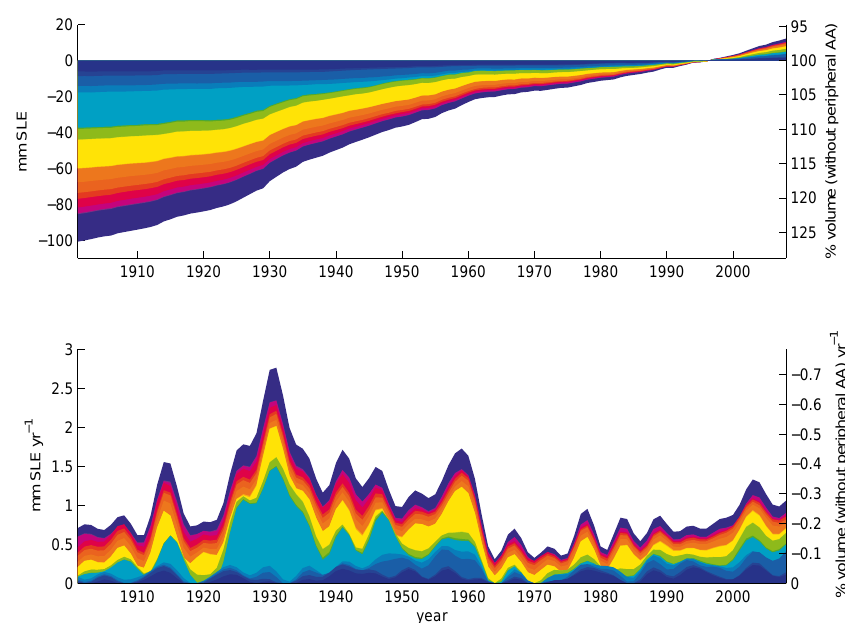
Fig. 18. Cumulative global surface mass balances relative to the 1986–2005 mean (upper panel), and rates (lower panel) from the CRU-forced model. Rates have been filtered with a 5yr low pass filter for